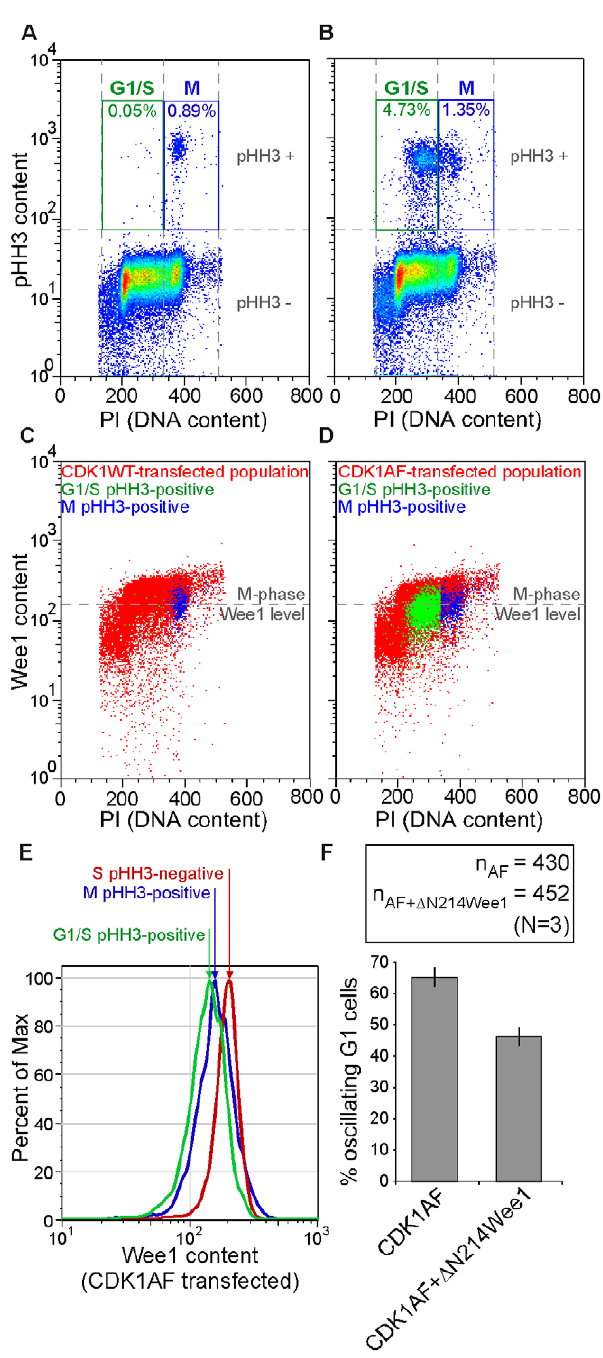
Figure 6. Premature M-phase initiation can be reduced in G1 cells with impaired APC-Cdh1 activation by enforced non- degradable Wee1 expression. (A) Fifty-thousand CDK1WT-trans- fected cells and (B) 50000 CDK1AF-transfected cells on a pseudo-color scatter plot of PI (abscissa) and pHH3 content (ordinate). High DNA and high pHH3 content (M phase) gates (blue ‘‘M’’) and low DNA and high pHH3 (abnormal G1/S cells) gates (green ‘‘G1/S’’) are shown with their respective frequencies. (C) Cells gated in (A) are overlaid on a pseudo- color scatter plot of PI (abscissa) and Wee1 content (ordinate) of CDK1WT-transfected cells. (D) Cells gated in (B) are overlaid on a pseudo-color scatter plot of PI (abscissa) and Wee1 content (ordinate) of CDK1AF-transfected cells. The M-phase Wee1 level (gray dashed line) is defined in both (C) and (D) by the horizontal axis centered on the Wee1-stained M-phase population that was gated in (A). (E)